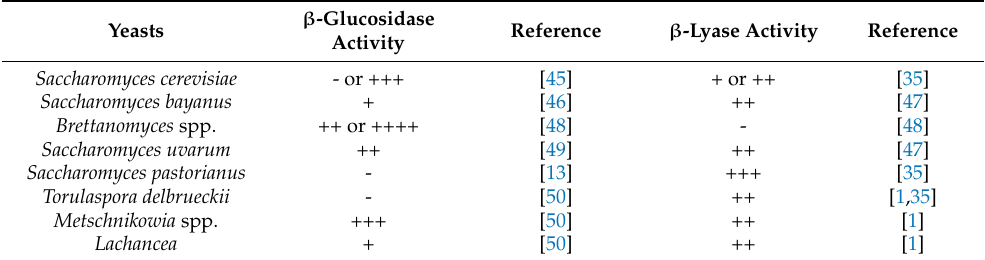
Table 1. Enzymatic activity associated with biotransformation in Saccharomyces and non-Saccharomyces